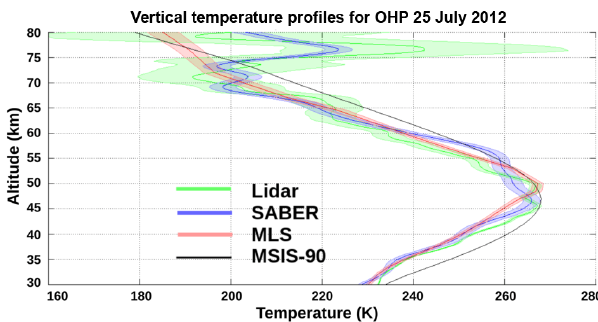
Figure 2. Example of co-located temperature profiles from the OHP lidar (green), SABER (blue), MLS (red), and MSIS (black).